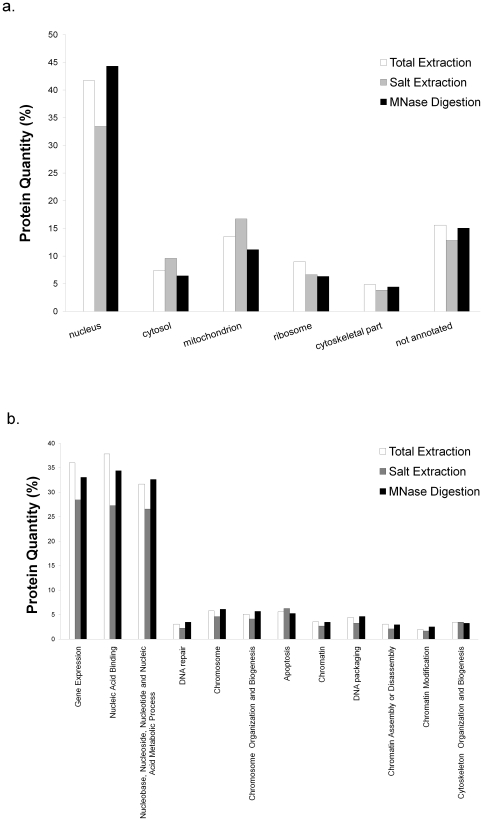
Classification of proteins identified in chromatin preparations.This was accomplished according to (a.) their cellular location and (b.) their functional categorization. The white column corresponds to the total extraction of chromatin, while gray and black columns correspond to the salt extraction and total digestion of chromatin respectively. Preparation fractions (supernatant and pellet) were combined where applicable. Protein quantity refers to the percentage of proteins in each category with respect to the total number proteins found in each particular preparation.